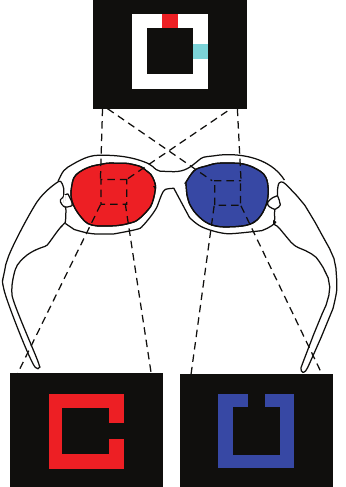
Figure 1: Stimulus paradigm of the interocular shift attention. The top of this diagram shows the training visual stimulus seeing through the anaglyphic glasses (shown in the middle); two eyes see different images (shown at the bottom). The task is to detect the opening direction of the image seen by the amblyopic eye, using a 4-alternative forced-choice (4-AFC) training paradigm.